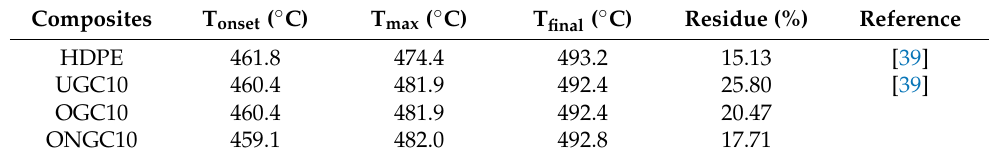
Table 5. Summary of TGA data for HDPE, UGC, OGC and ONGC (10% particle loading). Table 5 Summary of TGA data for HDPE, UGC, OGC and ONGC (10% particle loading). Composites